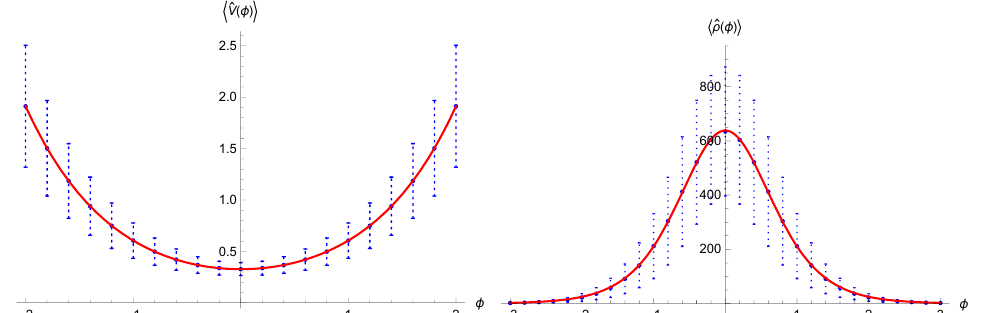
Figure 5. Expectation values of the volume ( left ) and of the energy density ( right ) as functions of time for k φ = 10 (blue dots), fitted with functions in accordance with the semiclassical evolution (full red lines). The error bars are calculated as the standard deviation of the corresponding operator.